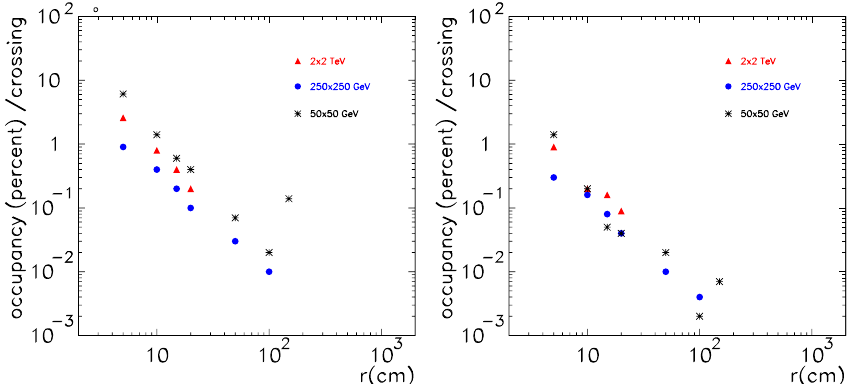
FIG. 65. (Color) Occupancy for 300 m m 3 300 m m silicon pads, as a function of the radius for the three energies studied. Left- hand figure shows the total occupancy and the right-hand figure shows the occupancy from hits resulting from charged